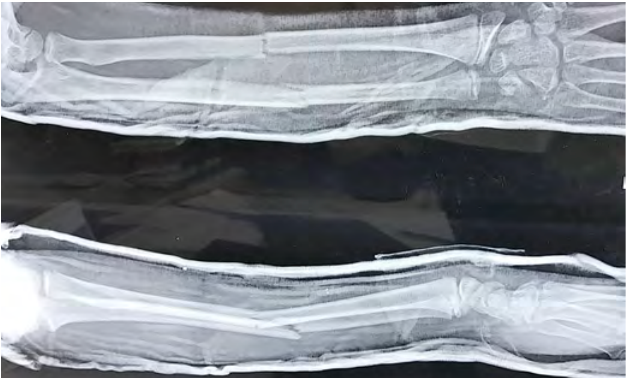
Fig 1 : X-ray of forearm showing both bone diaphysis